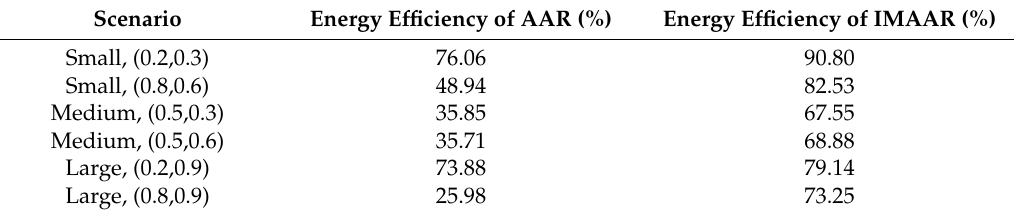
Figure 17. Maximum number of aggregations in each layer. Table 4. Energy efficiency of two